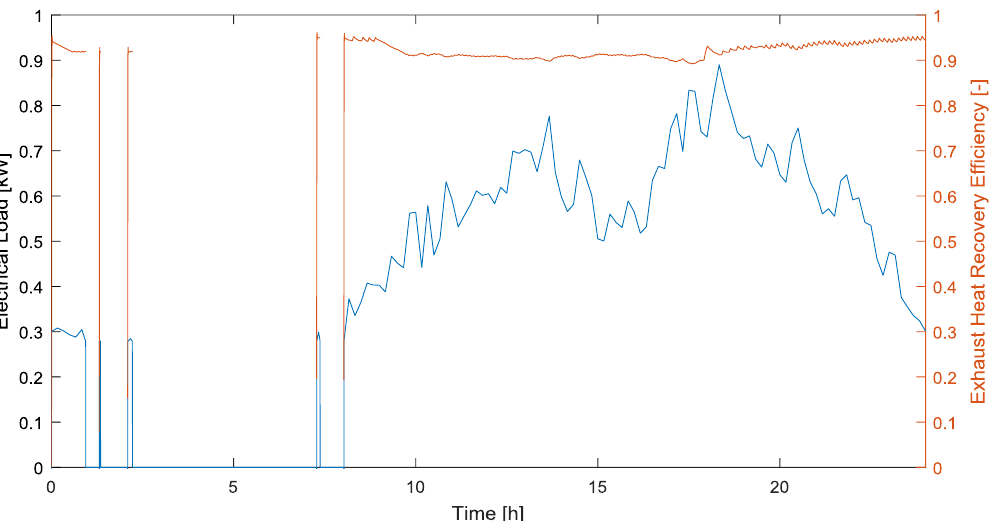
Figure 8. Plot of combined heat and power (CHP) Electrical Load and Exhaust Heat recovery efficiency curves vs. time.